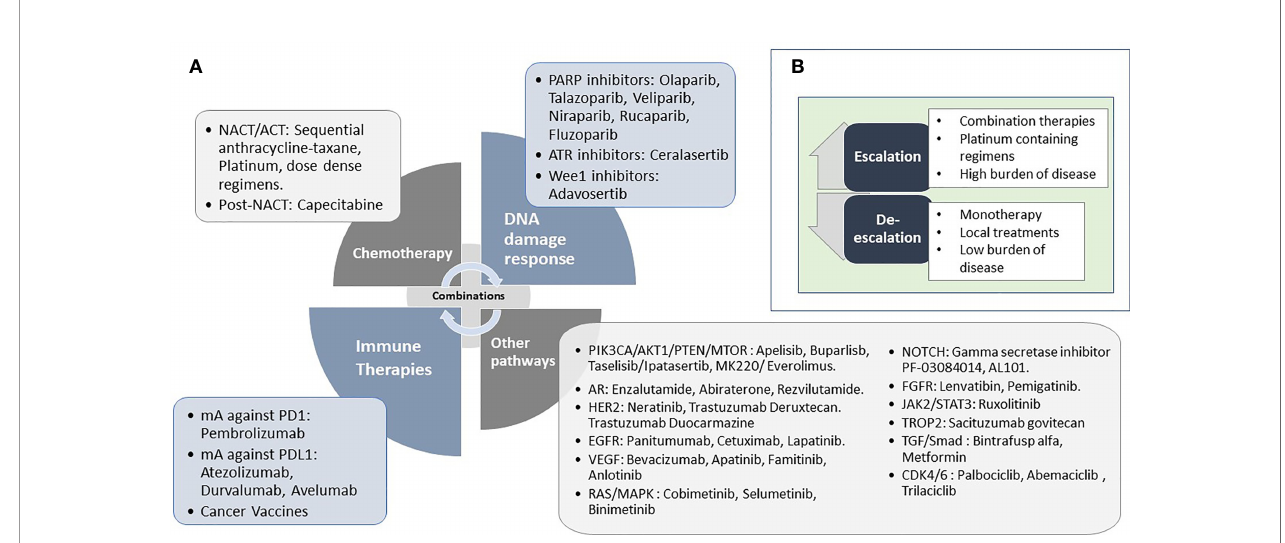
FIGURE 1 | Current therapeutics strategies in early TNBC. (A) . Treatment spectrum (B) . Treatment modalities for escalation and